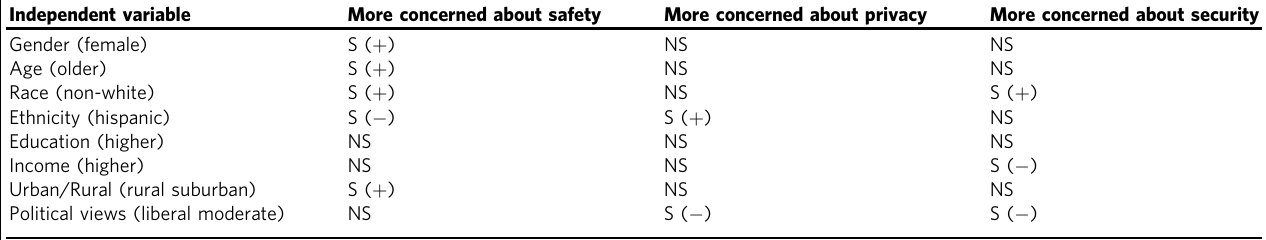
Table 5 Summary of the